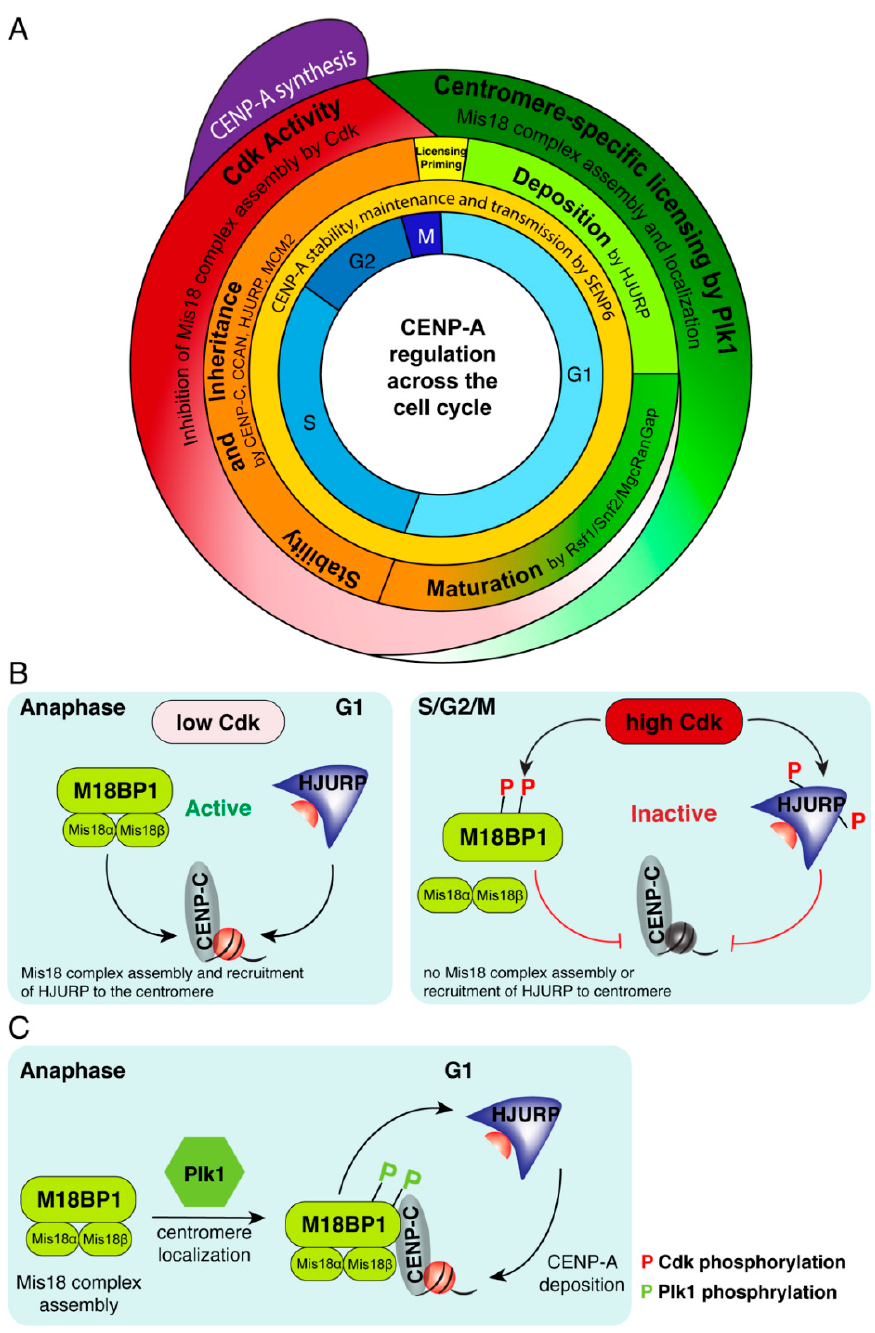
Figure 1. Centromere protein A ( CENP-A) deposition and maintenance are cell-cycle dependent. ( A ) CENP-A synthesis, deposition and maturation occur in distinct cell cycle phases and are regulated by coordinated activity of deposition, maturation factors and cell cycle kinases. ( B ) Cyclin-dependent kinase (CDK) regulation of Mis18 complex assembly. Phosphorylation of M18BP1 and Holliday Junction Recognition Protein (HJURP) by CDK1/2 renders them inactive, inhibits assembly of the Mis18 complex, and prevents HJURP recruitment to centromeres, preventing CENP-A deposition. At anaphase, low CDK1/2 levels result in active M18BP1 and assembly of Mis18 complex, recruitment of active HJURP and deposition of new CENP-A at the next G1. ( C ) Phosphorylation of M18BP1 by Plk1 is required for the assembly of the Mis18 complex and its localization to G1 centromeres. Once localized at centromeres by binding to CENP-C, HJURP is recruited to centromeres by binding to the Mis18 complex, leading to the subsequent deposition of new CENP-A.